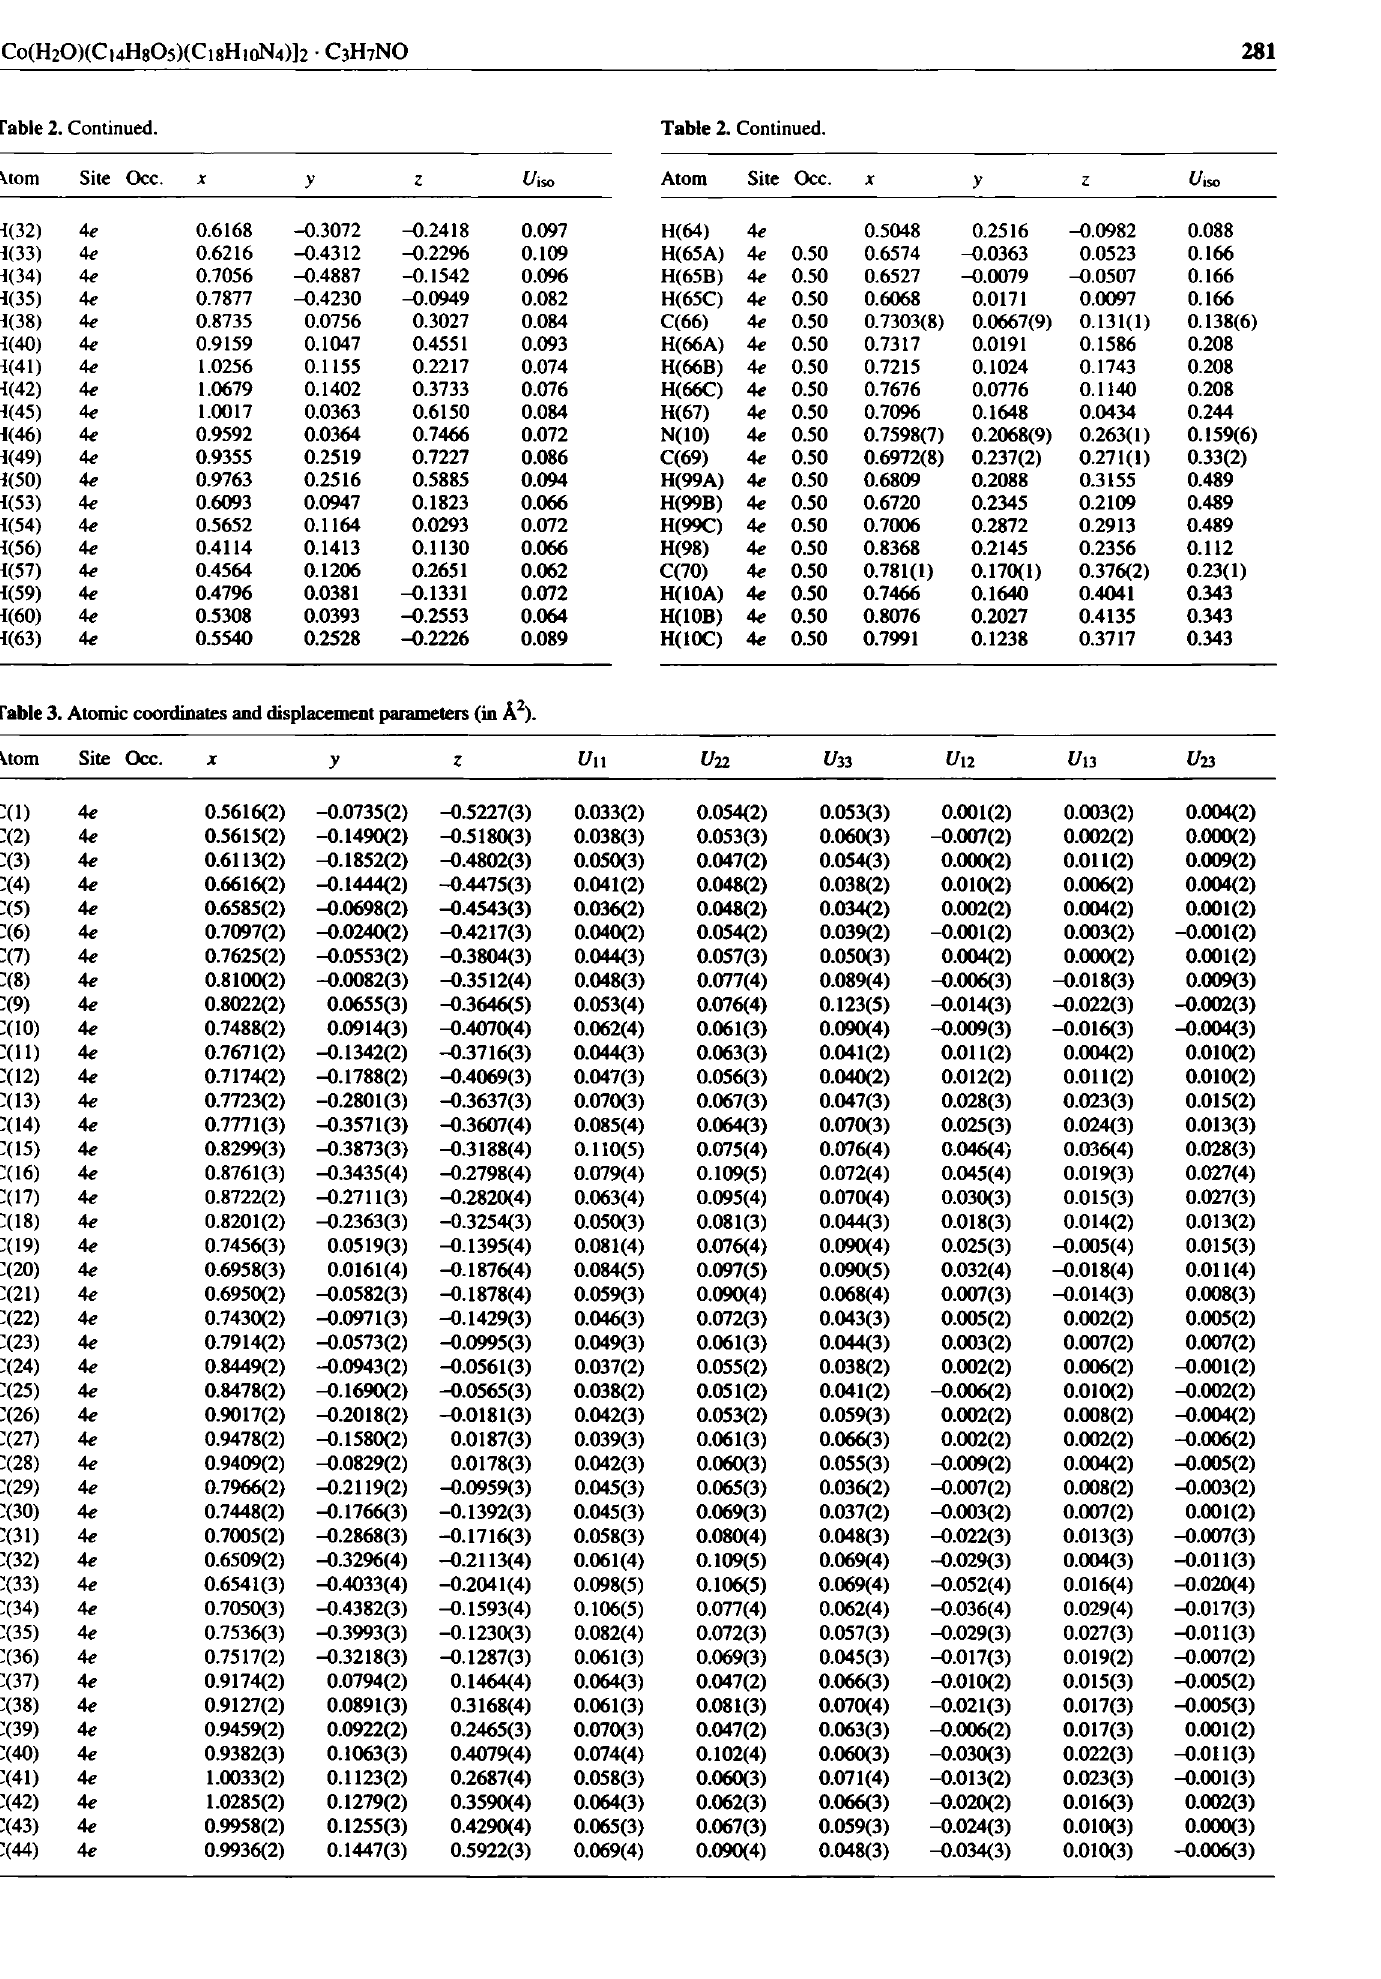
Table 3. Atomic coordinates and displacement parameters (in Â 2